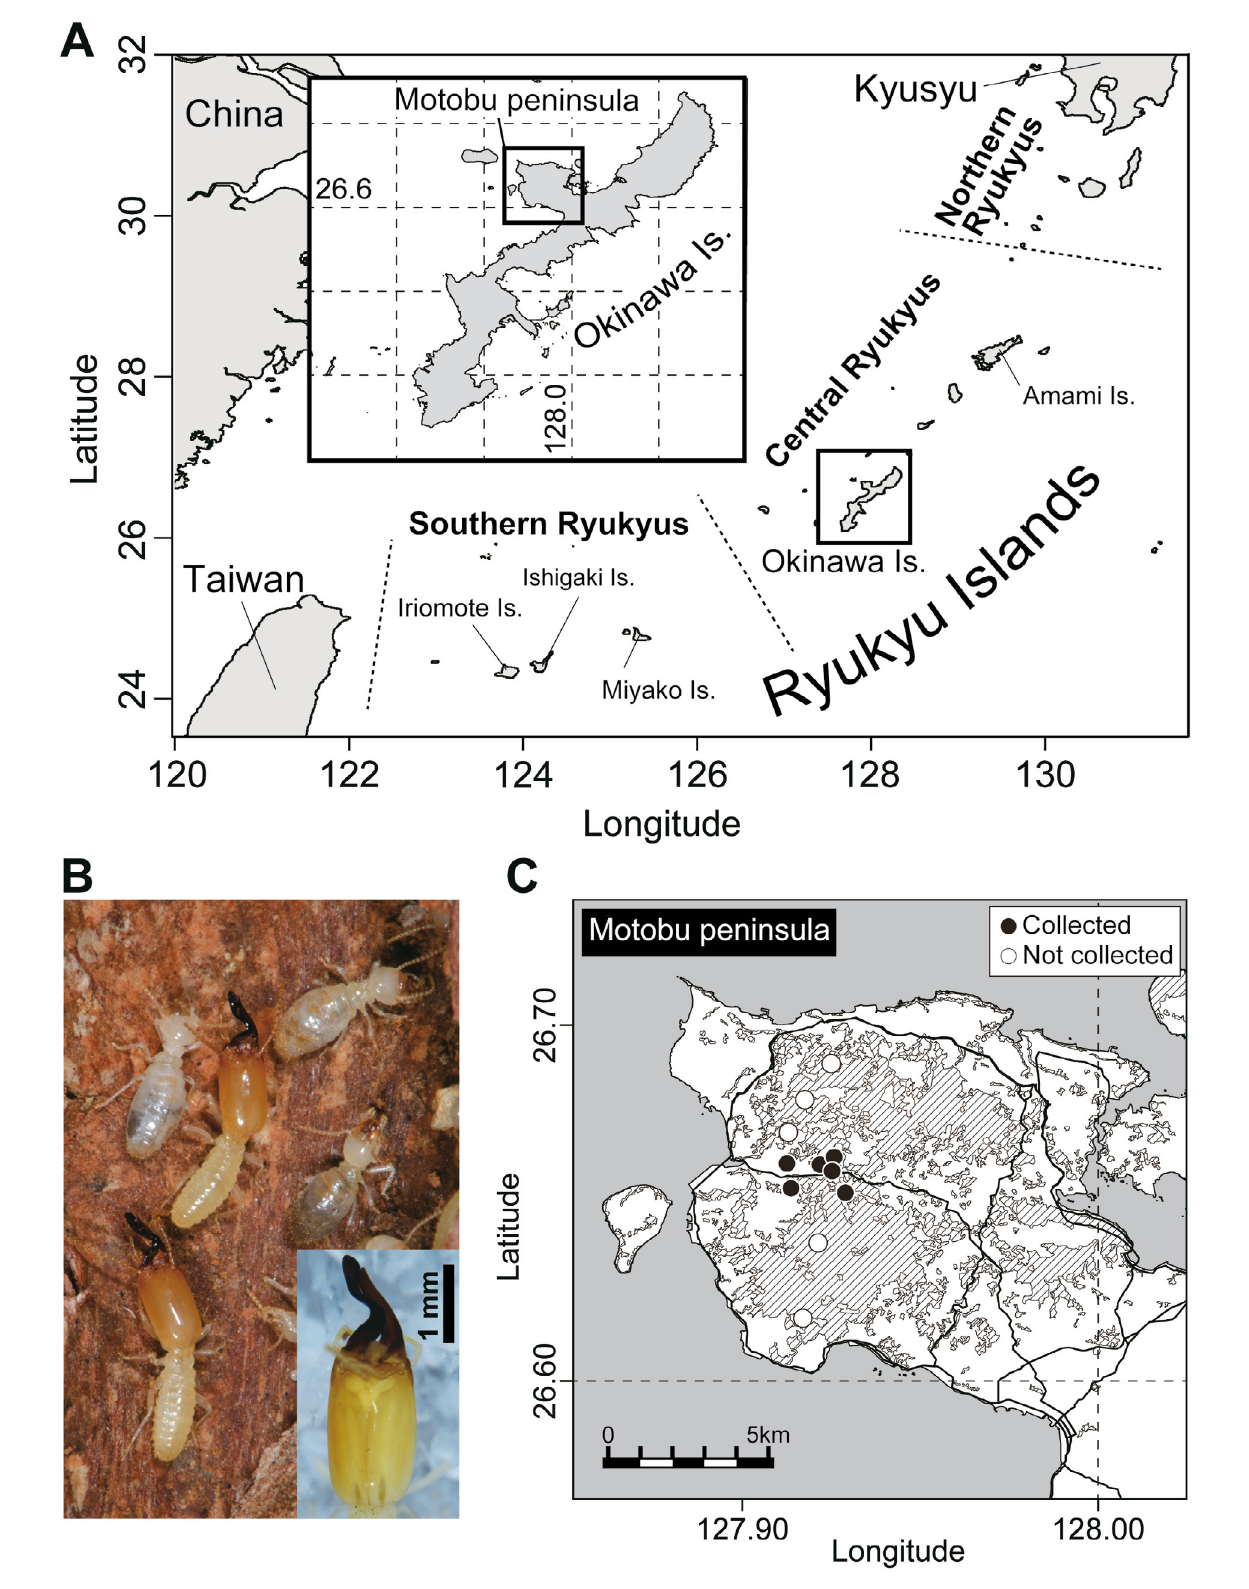
Fig 1. The soil feeding termite collected in the Motobu Peninsula of Okinawa Island. (A) The map of the Ryukyu Archipelago. (B) A photo of the termite, which was phylogenetically identified as Pericapritermes nitobei. The inset is an enlarged view of soldier head with a twisted left mandible and curved right mandible. (C) The map showing Motobu peninsula and the collection sites in the survey on June 2019. Filled and open circles indicate the presence and absence of the termite, respectively. Maps were drawn by the “maptools” in the R software (version 3.6.2; http://cran.r-project.org/) with the data provided by National Land Numerical Information, Ministry of Land, Infrastructure, Transport and Tourism, Japan